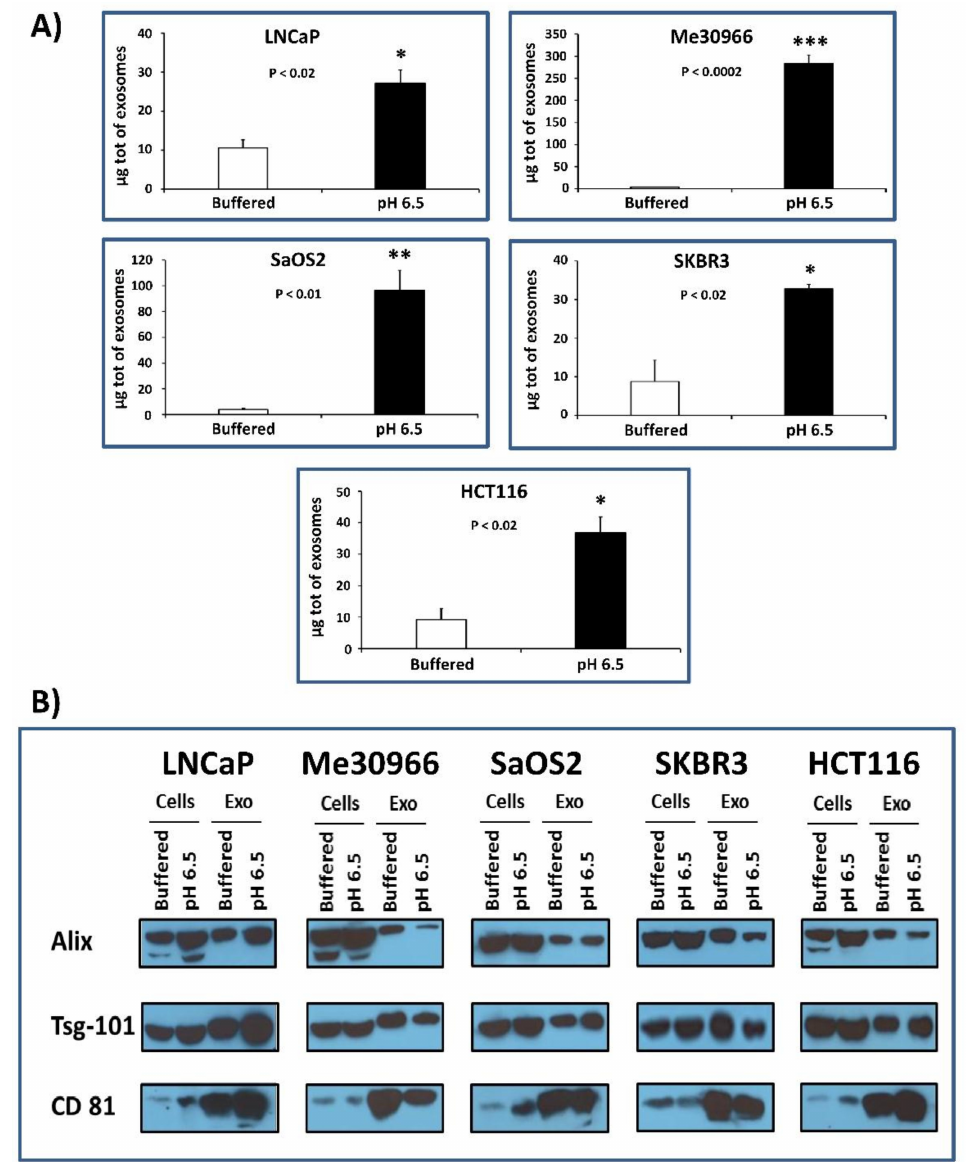
Figure 1. Protein quantification and characterization by Western blot analysis for housekeeping markers of exosomes. ( A ) Protein analysis of exosomes purified form several tumor cell lines (LNCaP, Me30966, SaOS2, SKBR3, and HCT116) cultured in both buffered and pH 6.5 conditions. Protein quantification was performed with the Bradford protein assay, and the exosomes were lysed using 3-((3-cholamidopropyl) dimethylammonio)-1-propanesulfonate (CHAPS) buffer. Means ± standard error (SE) of three different experiments are shown. The p -values were <0.02 in all cellular lines cultured in pH 6.5 with respect to buffered conditions. ( B ) Western blot analyses of alpha-1,3-mannosyltransferase (ALG-2)-interacting protein X (Alix), tumor susceptibility gene 101 (Tsg101), and cluster of differentiation 81 (CD81) proteins, performed in total protein extracts of several tumor cell lines (LNCaP, Me30966, SaOS2, SKBR3, and HCT116), cultured in buffered and pH 6.5 conditions, and exosomes purified from supernatants of the same cells. * p < 0.02, ** p < 0.01, *** p <